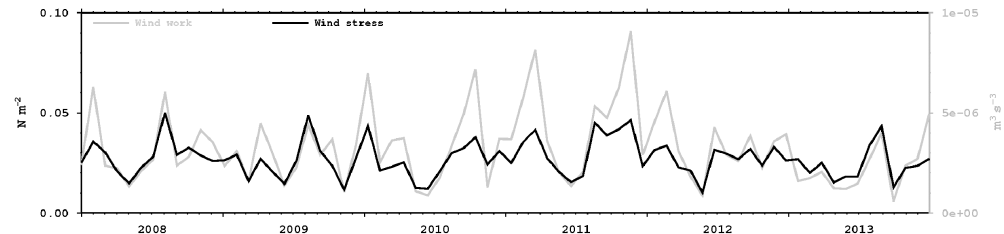
Figure 15. Monthly time series of the wind work (m 3 s − 3 ) and wind stress (Nm − 2 ) in the Sea of Marmara. The wind work normalised by the density and surface area of the Sea of Marmara is shown in grey in the right vertical axis. The wind stress is the black curve and its values are shown on the left vertical axis. Table 5. Annual means of volume fluxes (km 3 yr − 1 ) through the Dardanelles estimated by different studies. UL, LL and Net stand for upper layer, lower layer and net fluxes, respectively. A negative value indicates the volume flux is from the Sea of Marmara to the Aegean Sea. Northern Dardanelles Southern Dardanelles